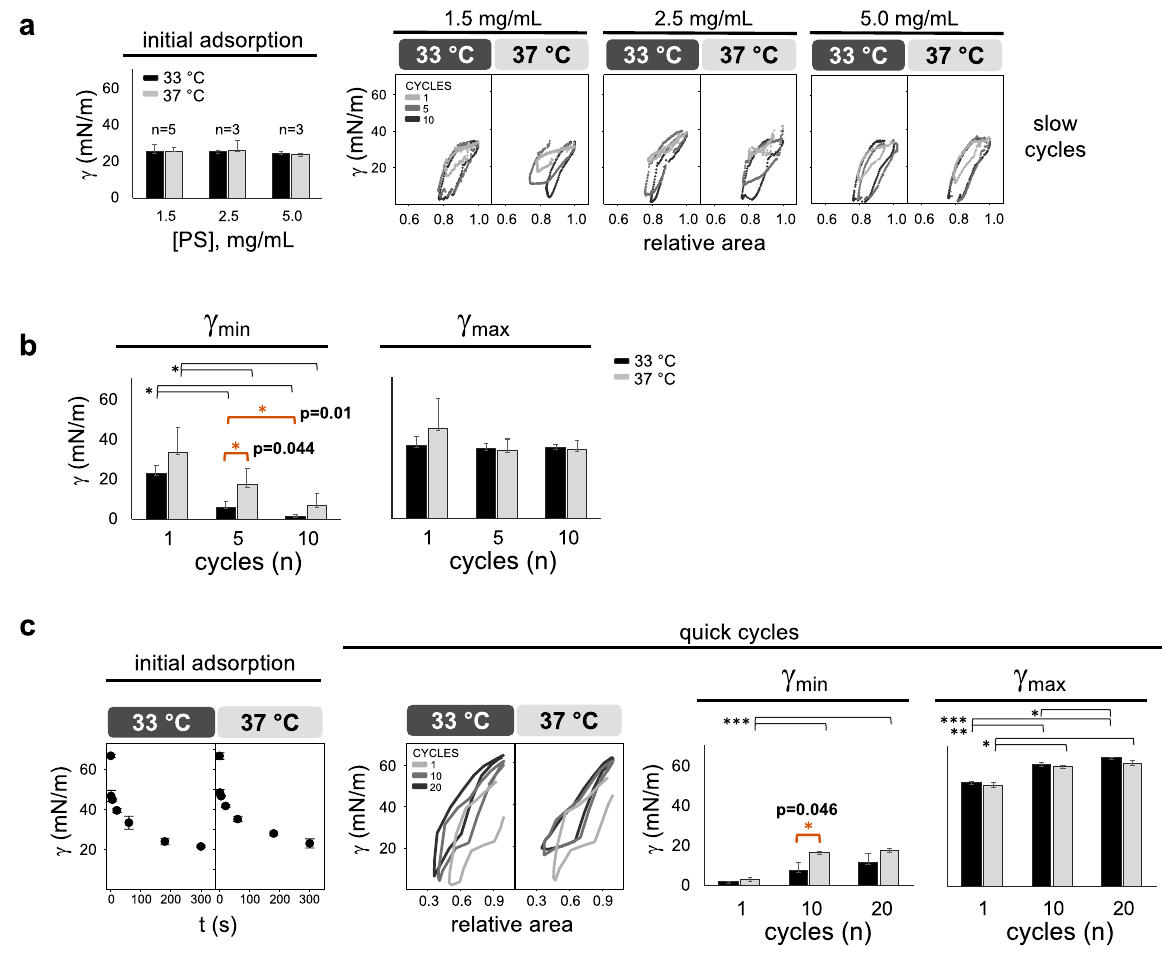
Figure 1. Changes in PS activity depending on temperature and concentration under slow and quick compression-expansion cycling. ( a ) CDS experiments under increasing concentration of PS (from 1.5 to 5 mg/ mL) at 33 °C and 37 °C. On the left, surface tension values (γ, mN/m) reached by PS 10 s after the buffer deposition on top of the pedestal (initial adsorption). On the right, one typical replicate of γ-∆area isotherms representative of the ten slow compression-expansion cycles (2 cycles/min, shrinking the interface area by 20%, 0.2 cm 2 /min). ( b ) Minimum and maximum surface tensions reached during cycles 1, 5 and 10, testing surfactant at limiting concentration (1.5 mg/mL, n = 5). ( c ) CBS experiments, using a PS concentration of 1.5 mg/mL at 33 °C and 37 °C. On the left, γ values reached during 5 min (300 s) of PS adsorption after injecting material onto the bubble (initial adsorption). In the middle, one representative replicate (n = 3) of γ-∆area isotherms under 10 quick compression-expansion cycles (20 cycles/min). On the right, minimum and maximum surface tensions reached during cycles 1, 5 and 20. Black and light-grey bars represent experiments performed at 33 °C and 37 °C, respectively. Means and standard deviation of at least three replicates are shown. Compression- expansion cycles are depicted in grey scale. Horizontal lines represent statistical comparisons. Two-way ANOVA test followed by post-hoc test = (a) initial adsorption: n. s.; (b) γ min : temperature (p = 0.002, D.F. = 1, F = 11.6) and cycles (p < 0.001, D.F. = 2, F = 30.2), γ max : n. s.; (c) initial adsorption: n. s.; γ min : temperature (p = 0.001, D.F. = 1, F = 20.2) and cycles (p < 0.001, D.F. = 2, F = 40.2), γ max : temperature (p = 0.003, D.F. = 1, F = 13.4) and cycles (p < 0.001, D.F. = 2, F = 180.1). *p < 0.05 and > 0.01, **p ≤ 0.01 and > 0.005, ***p ≤ 0.005. The exact p values of the most relevant post-hoc tests are indicated. The corresponding comparison bars and symbols are highlighted in orange color. PS purified porcine surfactant, γ surface tension, min minimum, max maximum, n. s. not significant, D.F. degrees of